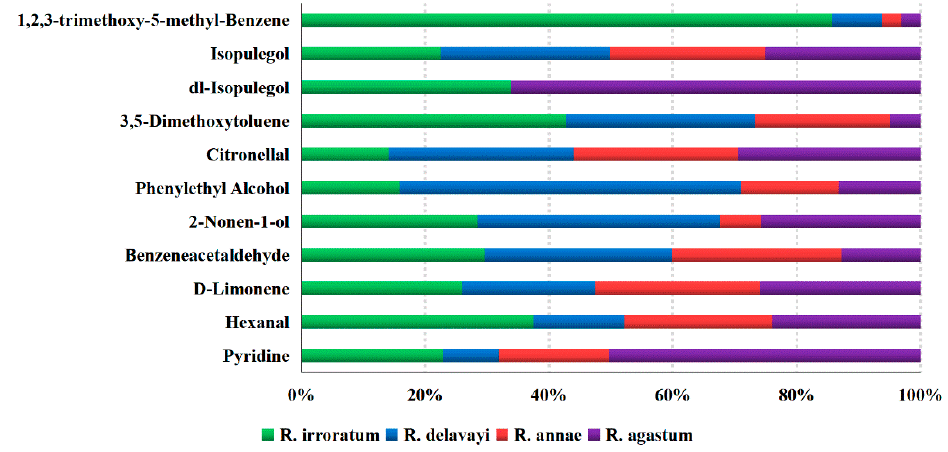
Figure 3. Distribution (%) of major compounds presented in four different species of Rhododendron .